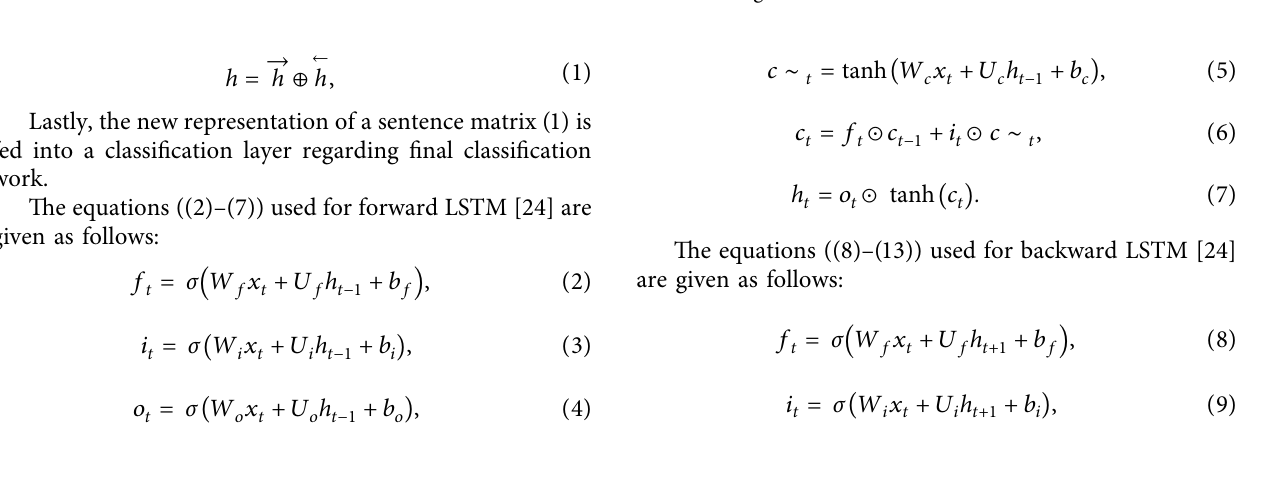
Figure 3: The Bi-LSTM model architecture concerning emotion